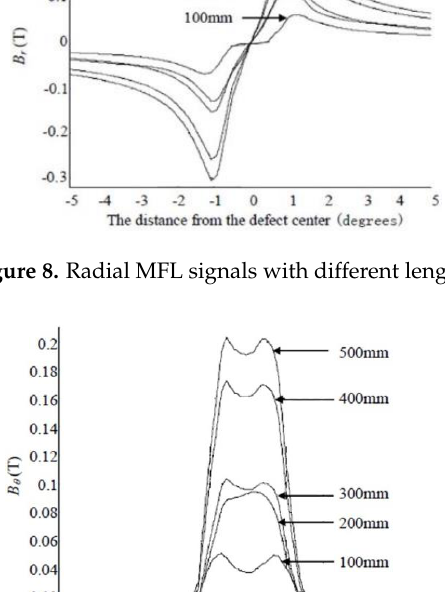
Figure 9. Circumferential MFL signals with different length.